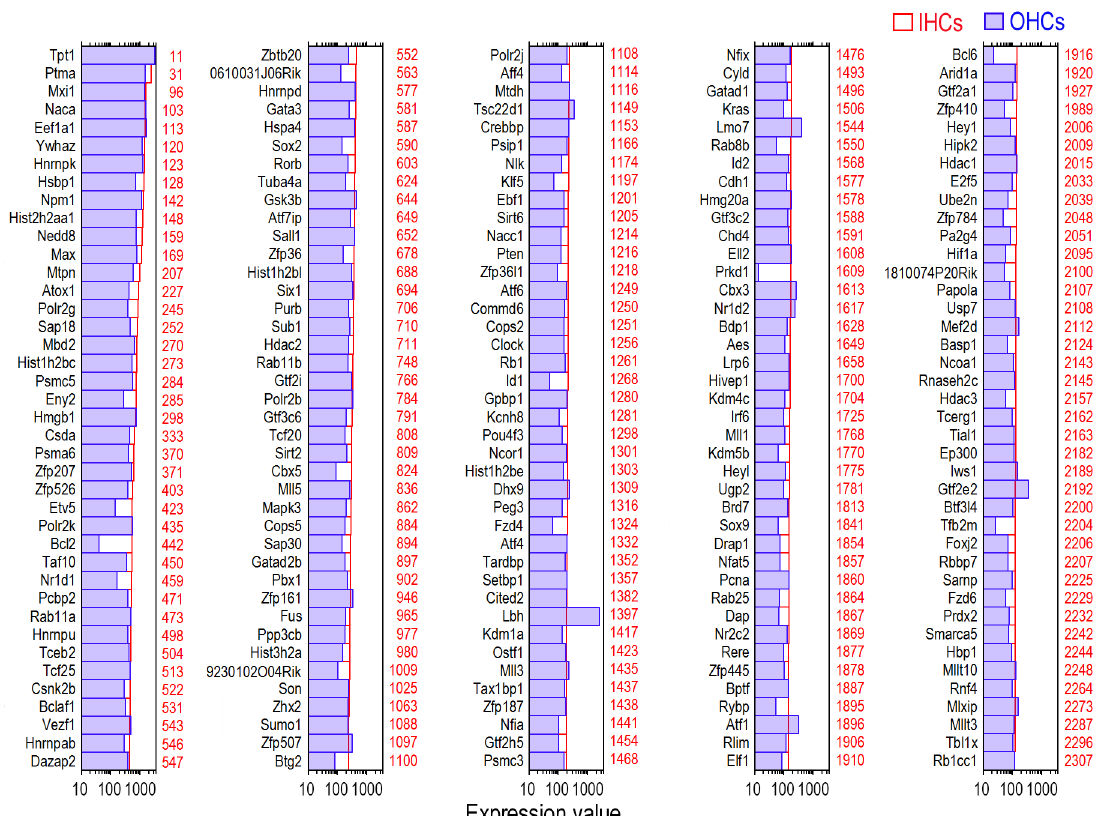
Fig 1. Expression levels of the top 200 TF genes in adult IHCs (in red) in descending order. For comparison, the expression value of the same genes in adult OHCs (in blue) is also presented. Color-coded numbers on the right side of each panel represents the abundance ranking of the each TF among 16,647 transcripts considered to be expressed in adult